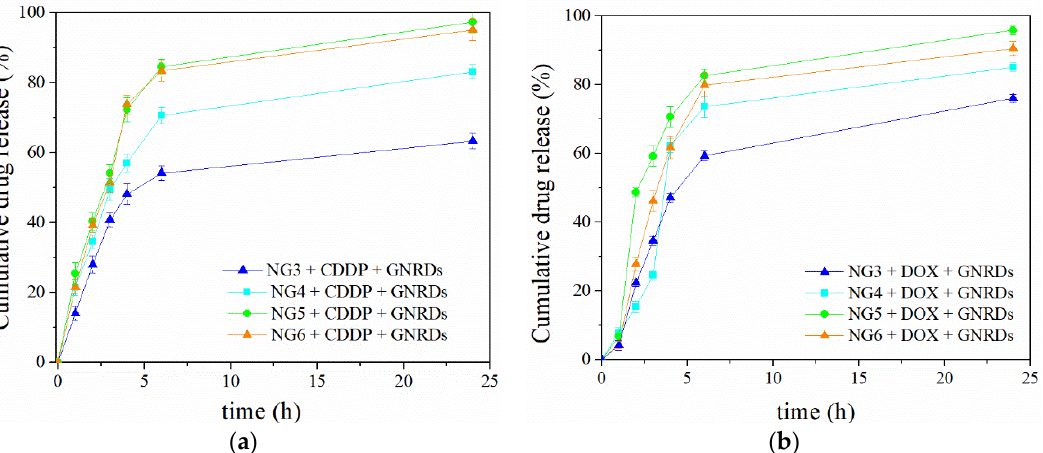
Figure 9. Cumulative drug release at pH 7.4 and 37 °C from PNVCL:VP:PEGMA and PNVCL:GAL:PEGMA nanogels with GNRDs. The samples were irradiated with an NIR laser (500 mW) for 10 min every hour until 6 h followed by a measurement after 24 h of total incubation time: ( a ) nanogel-CDDP-GNRDs and ( b ) nanogel-DOX-GNRDs.